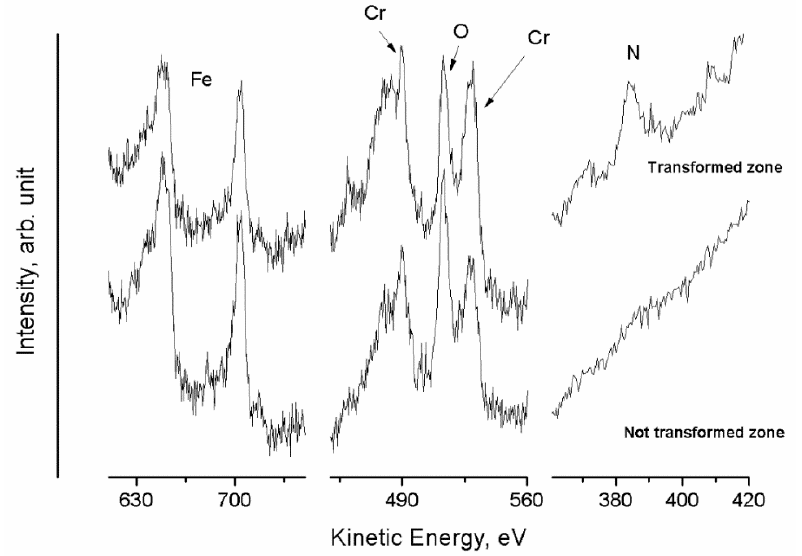
Figure 28. Auger spectra (Fe LMM, Cr LMM, O KLL, and N KLL) of untransformed and transformed zones of the steel sample after 23 h at 850 °C [40].